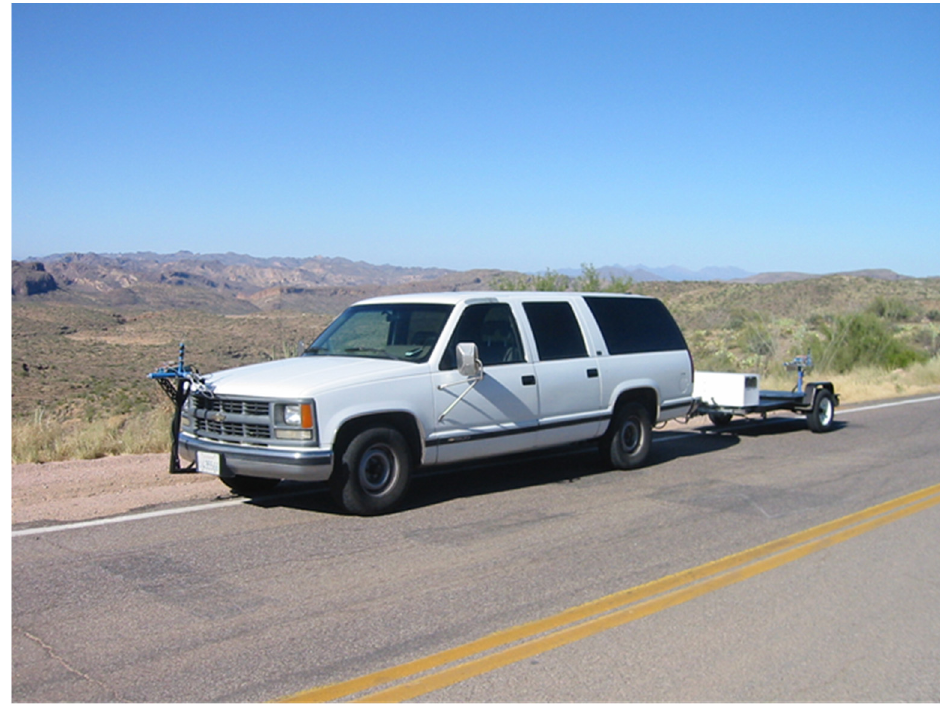
Figure 2. Photograph of the